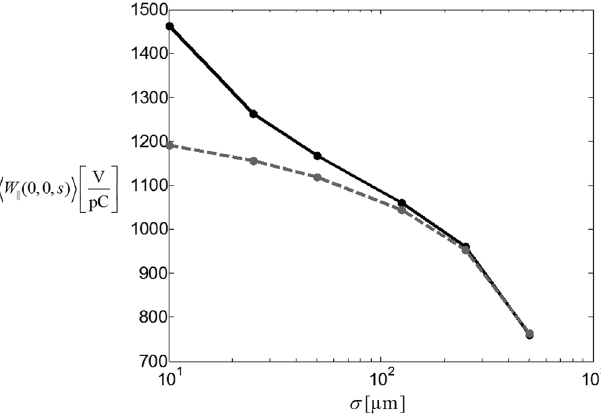
FIG. 11. Loss factor for very short bunches in the dechirper (in black). The grey symbols give the difference between the loss factors for 2 m-long structure and a 1 m-long